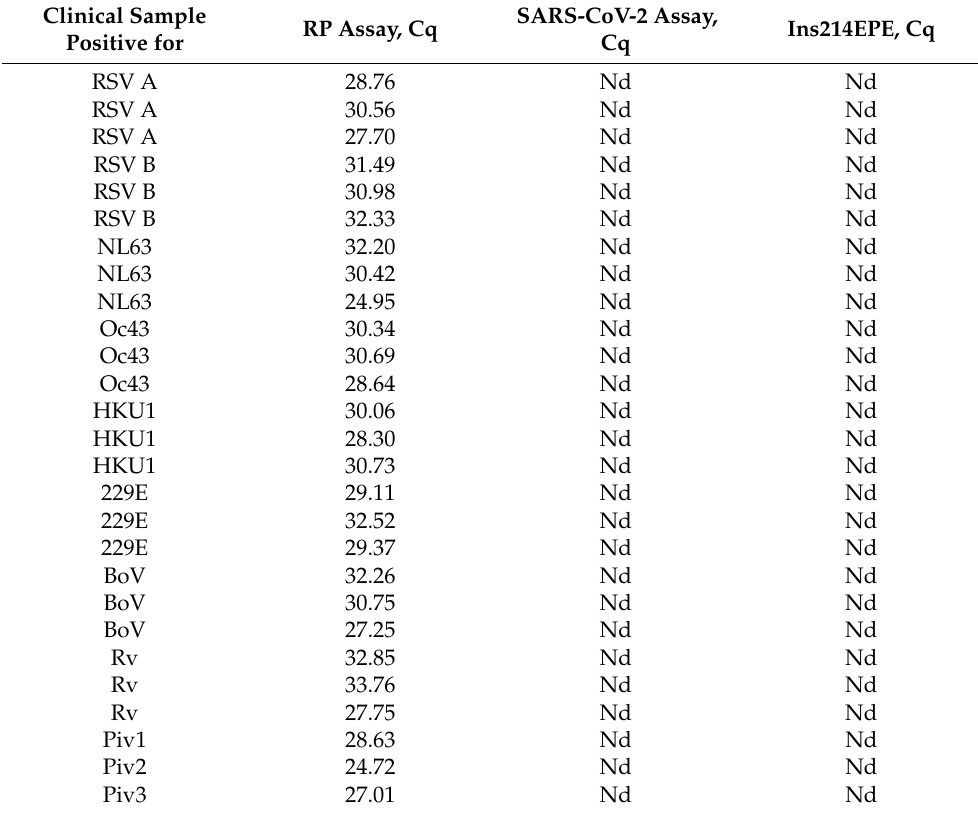
Table A2. Analytical specificity of the multiplex qPCR assay tested on 33 clinical samples positive for other respiratory viruses. The RP assay (human RNAse P assay) developed by US CDC was used to check for the presence of human RNA in clinical samples. “Nd”—Not detected.